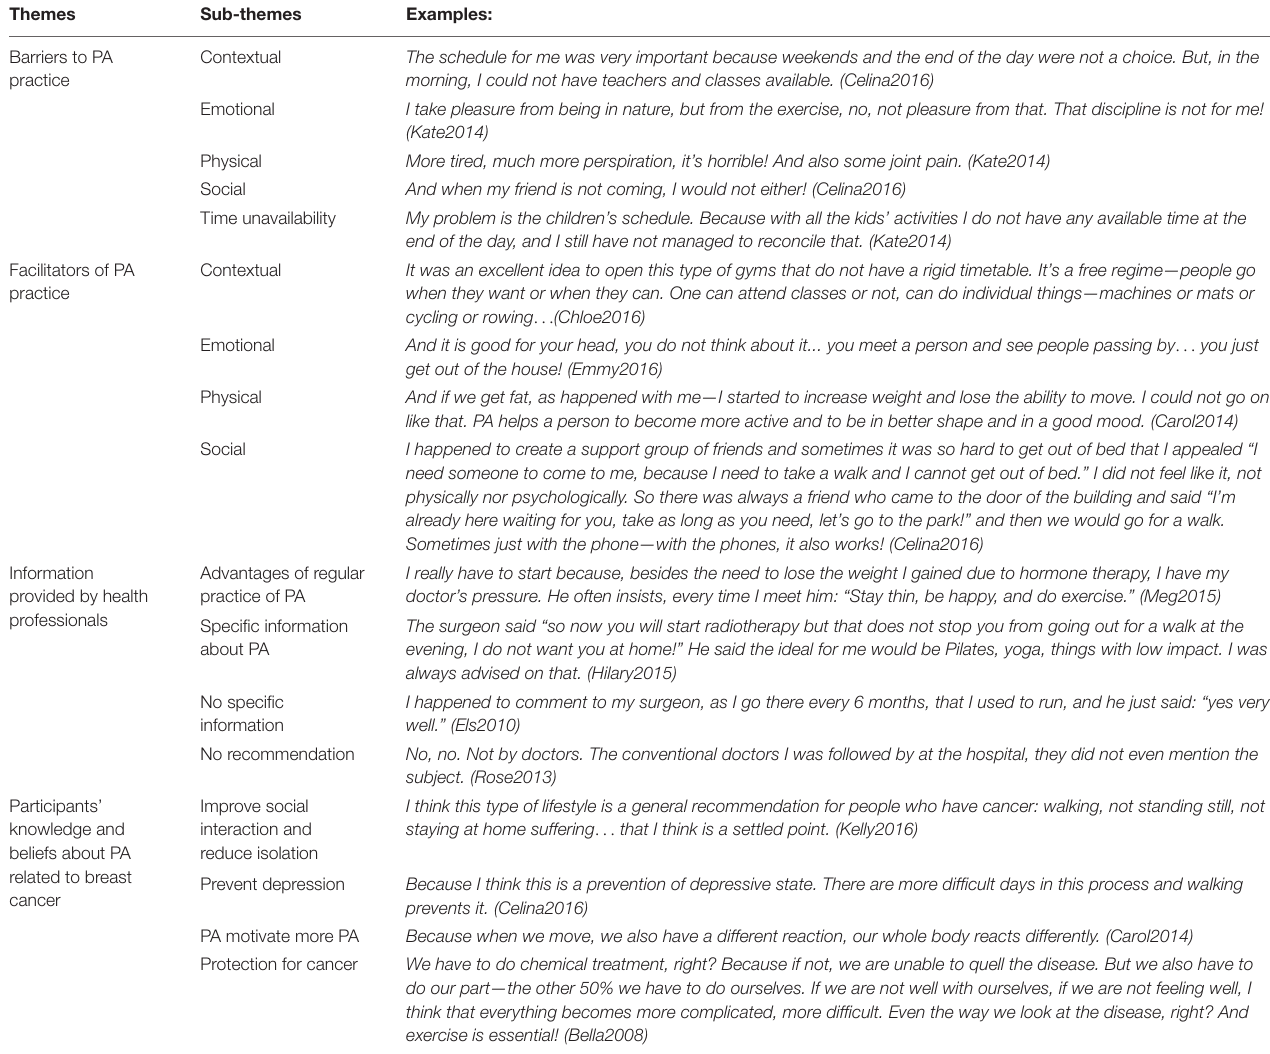
TABLE 2 | Key themes and sub-themes identified in the interviews. Themes Sub-themes Examples: Barriers to PA